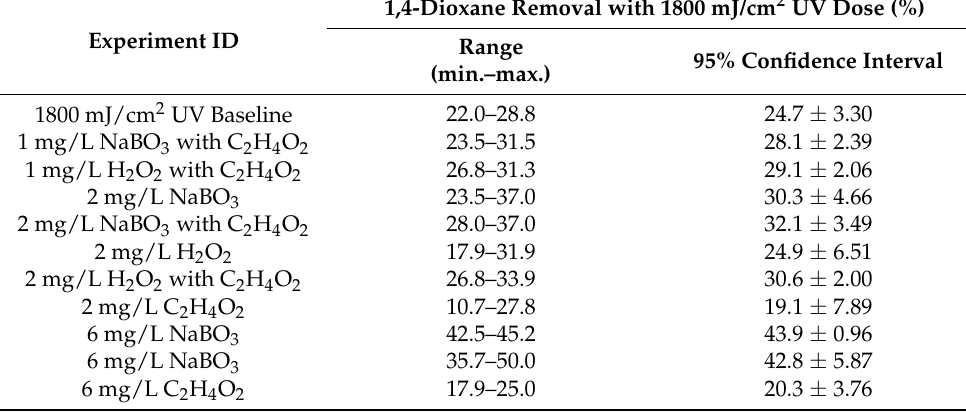
Table 3. 1,4-Dioxane Experimental Results Summary ( ≥ 50 µ g/L initial 1,4-dioxane